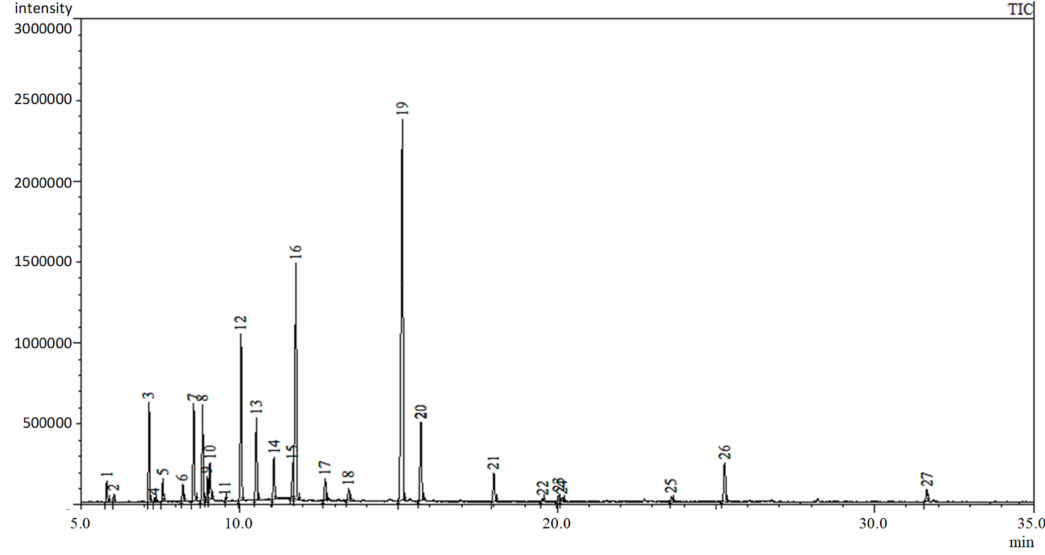
Figure 1. Total ion chromatogram of the essential oil of Origanum majorana